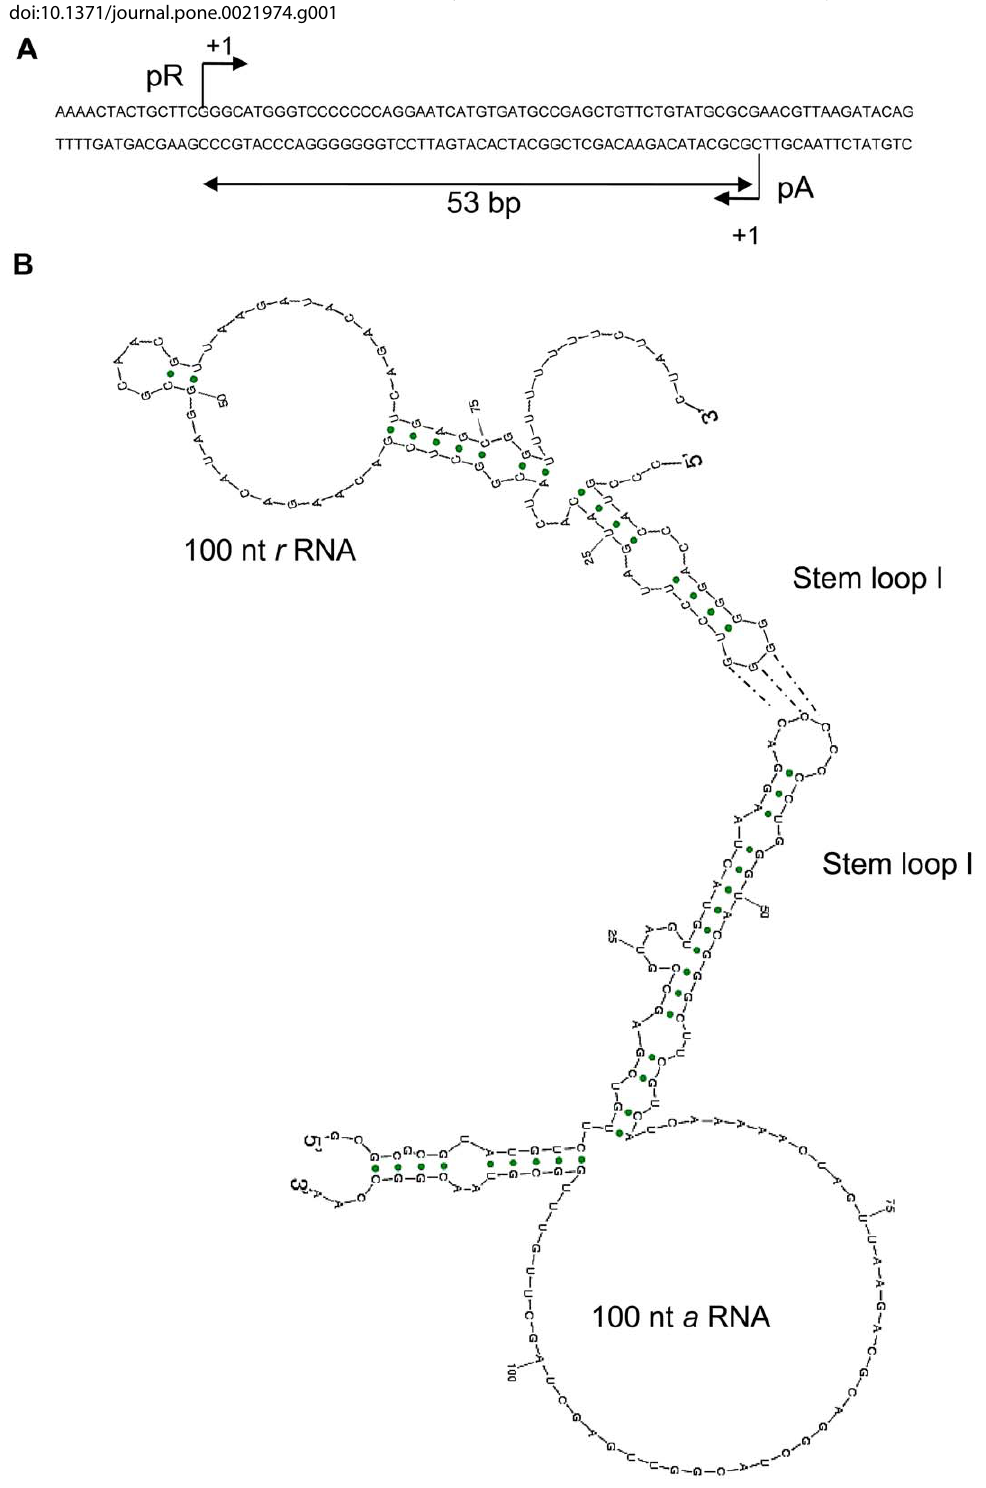
Figure 2. Antisense RNA within scbA-scbR overlapping locus. ( A ) Overlapping DNA sequence of scbR-scbA locus. ( B ) In silico RNA secondary structures of 100 nt pR and pA transcript representing the structures of full-length r and a RNA respectively. Stem loop I present on both nascent a and r RNA contain complementary single stranded regions. doi:10.1371/journal.pone.0021974.g002 PLoS ONE |